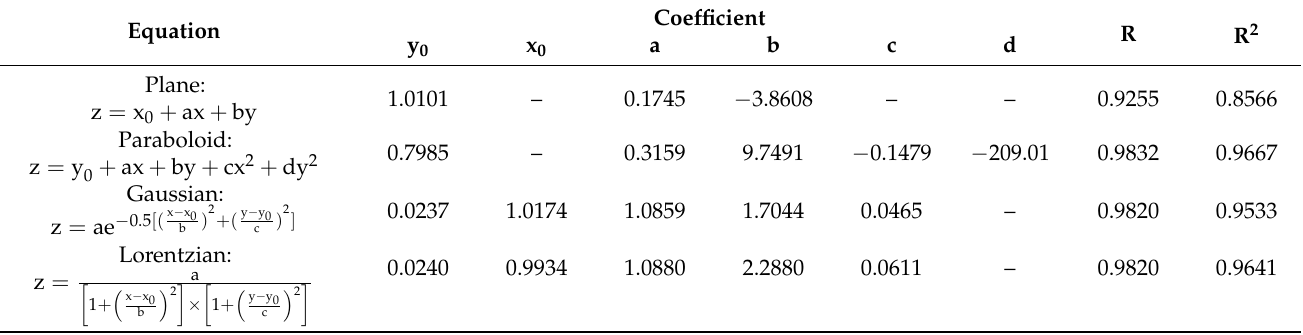
Table 1. Approximation functions and their coefficients for Figure